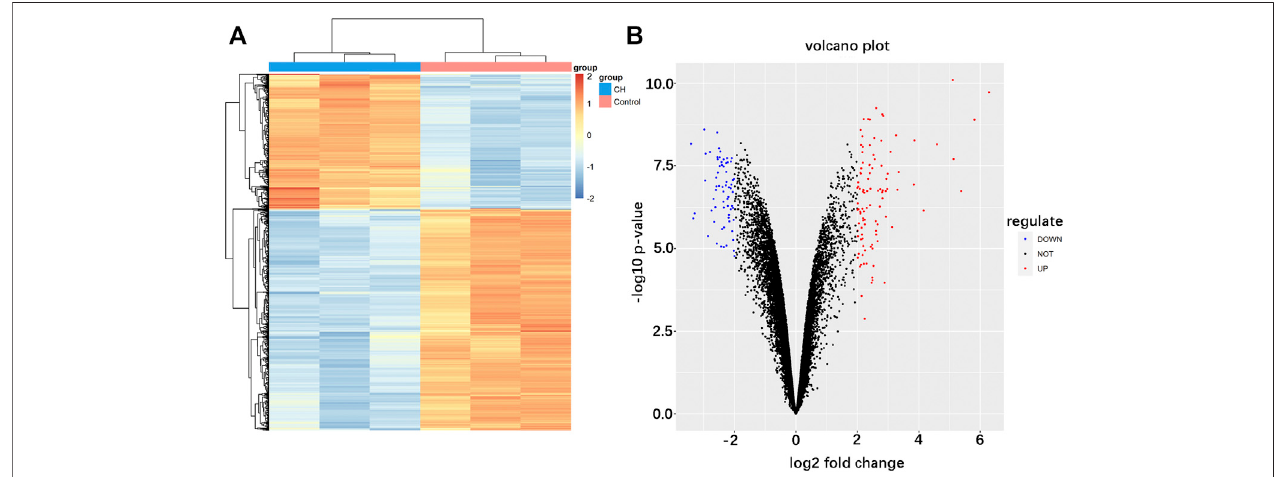
FIGURE 2 | Identi fi cation of differentially expressed mRNAs in cardiac hypertrophy. (A) Hierarchical clustering heat map of differentially expressed mRNAs. (B) Volcano plot of differentially expressed mRNAs. Red represents upregulated mRNAs and green represents downregulated